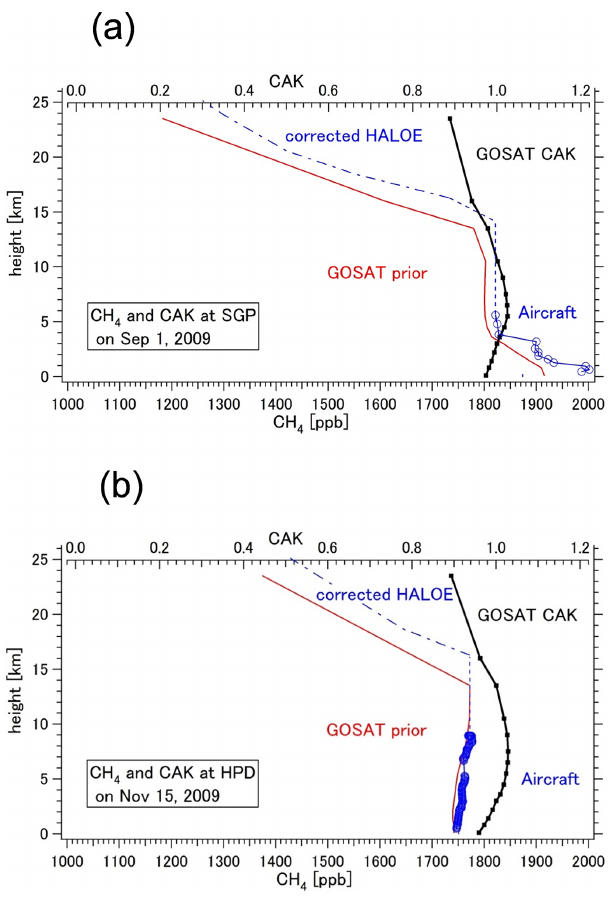
Figure 7. Temporal variations of XCH 4 with and without CAK at (a) the Southern Great Plains (SGP) and (b ) Park Falls (LEF). Red and black dots indicate XCH 4 with and without the application of CAK, respectively, and the triangles show their